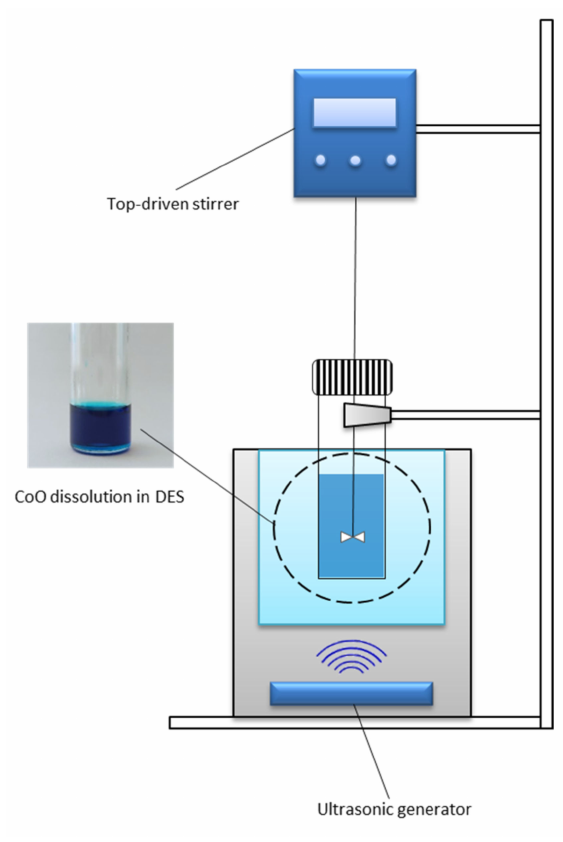
Figure 1. Experimental setup. Metal concentration in DES after the oxide dissolution was determined spectropho- tometrically after the pretreatment with 4-(2-pyridylazo)-resorcinol with formation of complexes absorbing in a visible spectrum at the following wavelengths (nm): Ni (495), Mn (499), Co (510) [36]. Optical densities were measured on Cary-60 (Agilent Tech, Santa Clara, California, United States) device in glass cuvettes with an optical path length of 10 mm. The concentration determination error was